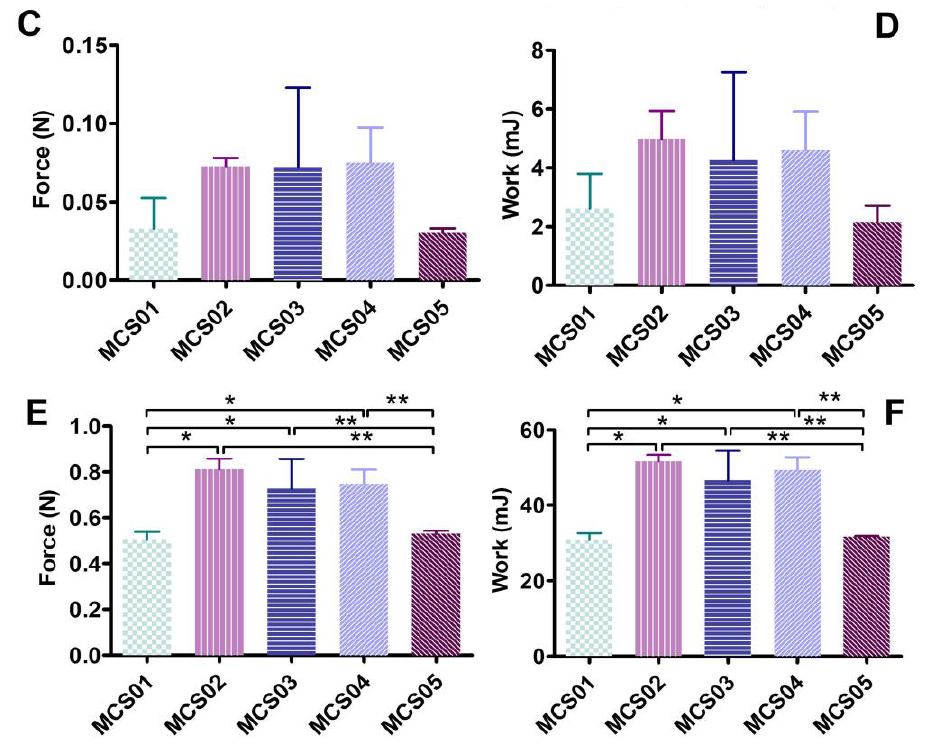
Figure 2. Syringeability results of maximum force and work, respectively; ( A , B ) using 1 mL syringes; ( C , D ) using 5 mL syringes; ( E , F ) using 50 mL syringes. Data are expressed as mean ± SD ( n = 3). * Statistically significant differences regarding MCS01 ( p < 0.05). ** Statistically significant differences regarding MCS05 ( p < 0.05).